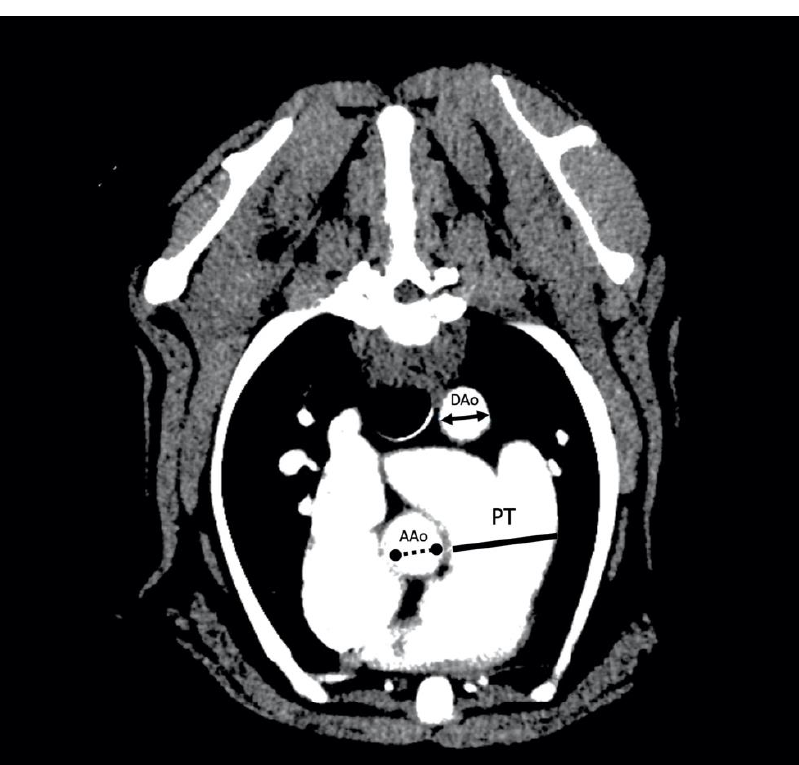
Figure 1. Arterial-phase postcontrast transverse thoracic angiogram CT image at the level of the pulmonary trunk (PT) in a 16 kg male beagle with an RPAD index of 17%. The PT to aorta ratio measurement technique consists of the measure of the maximum diameter of the PT measured immediately ventral to the bifurcation into left and right pulmonary arteries (solid line) and the measure of the short axis of the diameter of the descending part of the aorta (DAo) (solid line double arrow) or the short axis of the diameter of the ascending part of the aorta (AAo) (no solid line double arrow). The PT:DAo ratio of this dog was 1.72 and the PT:AAo ratio was 1.47.